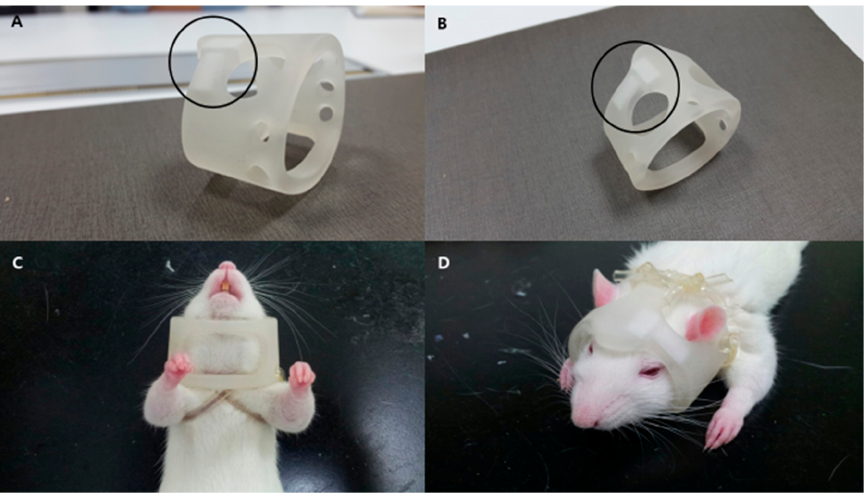
Figure 11. Photographs of the magnet-embedded helmet and its application. Two magnets were embedded under a helmet made by a 3D printing method, as shown in the ( A ) lateral and ( B ) oblique views. The black circles indicate the positions of the two magnets. The helmet was attached to the rat just to the extent that it would move freely with flexible polyvinyl chloride laboratory tubes, as shown in the ( C ) bottom and ( D ) top